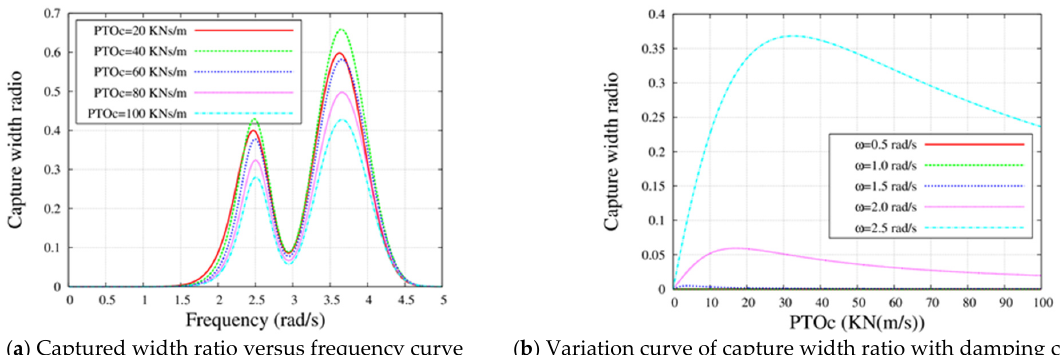
was small. When the wave frequencies were tion response of the device increased with the increase in the PTO damping coefficient, but the increase rate was small. Figure 11. The capture width ratio of the MJWEC for different radius ratios and draft ratios. Figure 11. The capture width ratio of the MJWEC for different radius ratios and draft ratios.